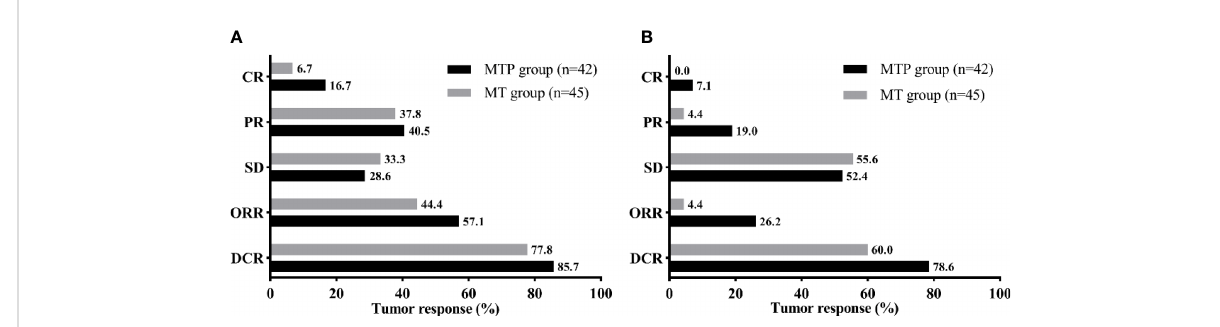
FIGURE 2 Tumor response of the intrahepatic targeted tumor (A) and overall tumor (B) for the two groups. MTP, microwave ablation and transarterial chemoembolization combined with PD-1 inhibitor; MT, microwave ablation and transarterial chemoembolization; CR, complete response; PR, partial response; SD, stable disease; ORR, objective response rate; DCR, disease control rate.